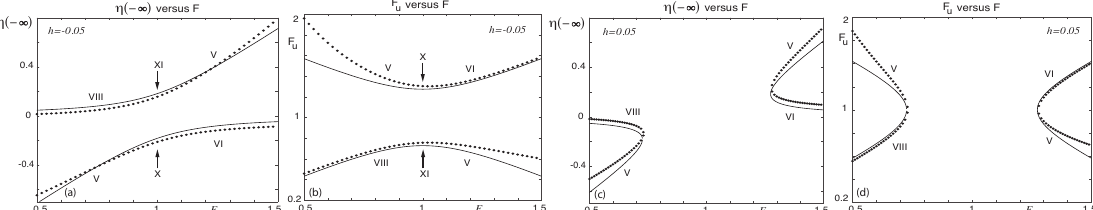
Figure 8. Comparison of the KdV model results (solid curves) with exact solutions of the full problem (broken curves) for a step, h , in the channel bed [54]. The solutions are waveless or uniform both far upstream and downstream and the basic flow types are indicated on the plots. ( a , c ) Uniform free-surface elevation far upstream, η ( − ∞ ) , versus the downstream Froude number, F. ( b , d ) Upstream Froude number, F u , versus the downstream Froude number, F. ( a , b ) h = − 0.05 and ( c , d ) h =